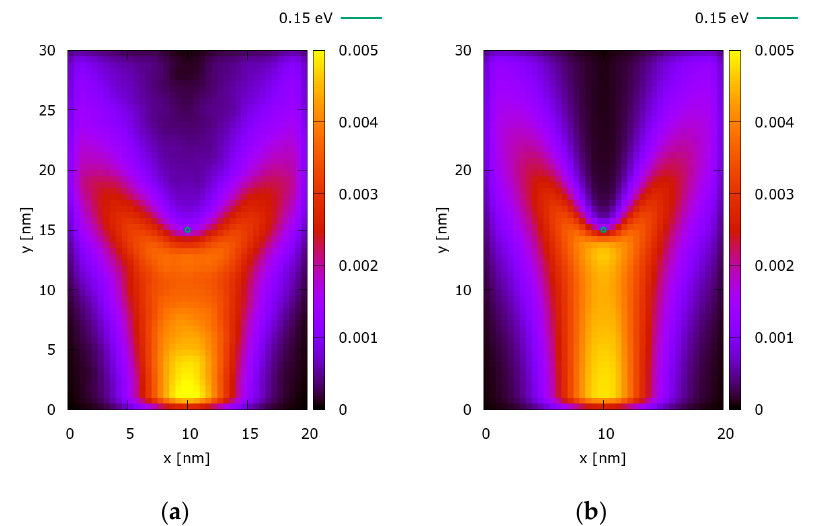
+ (𝑥, 𝑦) . Figure 2. Spatial distribution of ( a ) the negative part f − ( x , y ) . w xy 𝑤 𝑥𝑦